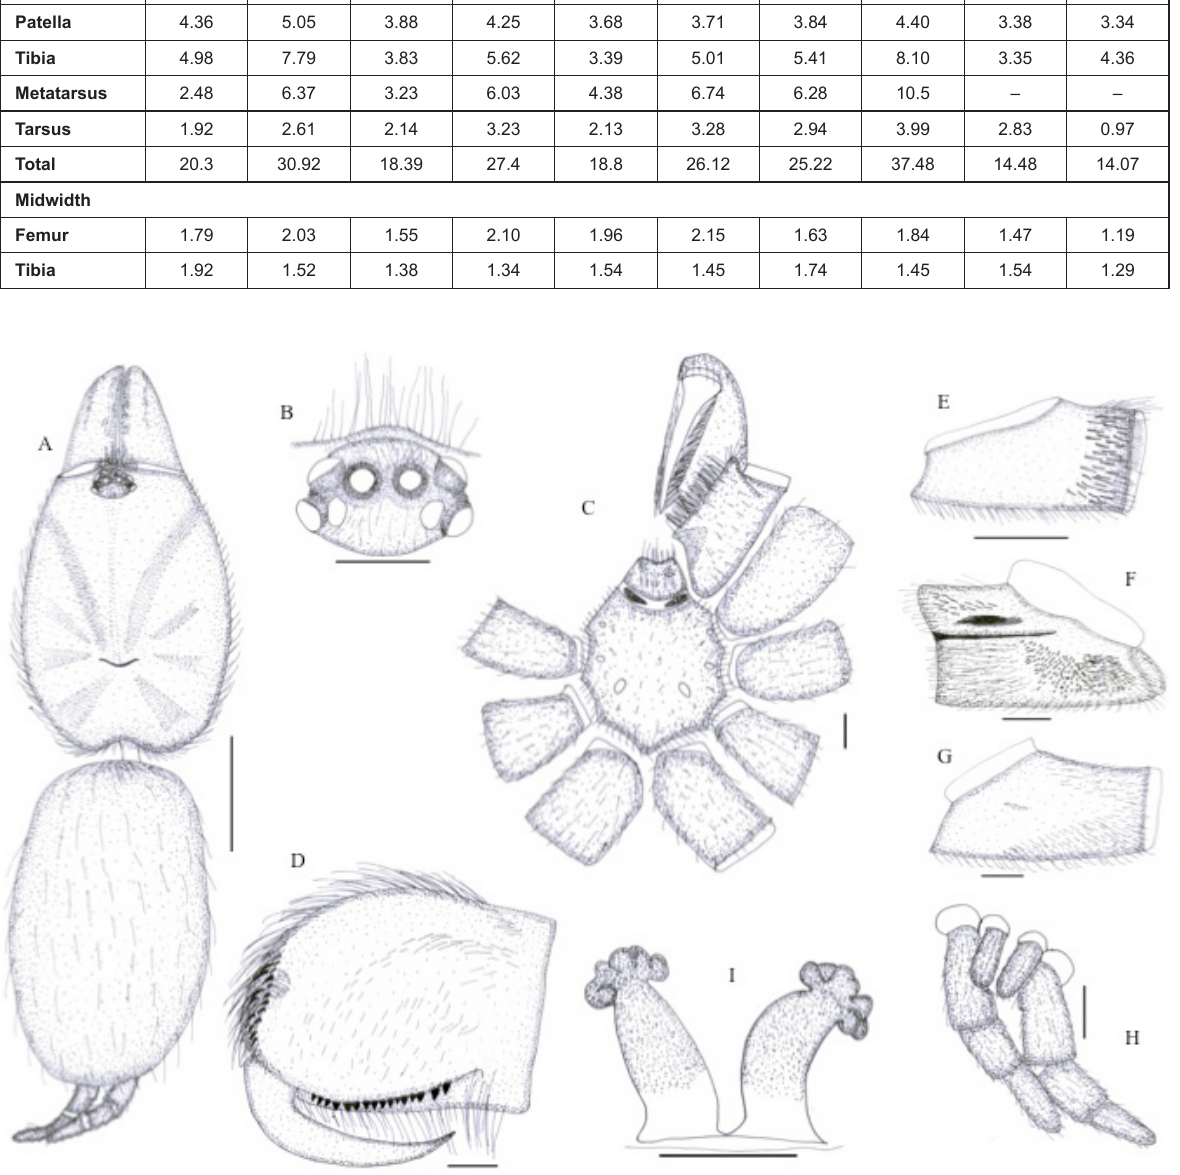
Figure 4. Neoheterophrictus sahyadri sp. nov., female (WILD-10-ARA-1008). A - Carapace and abdomen dorsal view; B - Eye; C - Sternum, maxillae, labium, chelicerae; D - Chelicerae prolateral view; E - Maxillae, retrolateral view; F - Coxa I, prolateral view; G - Coxa I, retrolateral view; H - Spinnerets; I - Spermathecae. Scale 1.0mm for B–I and scale 0.5mm for